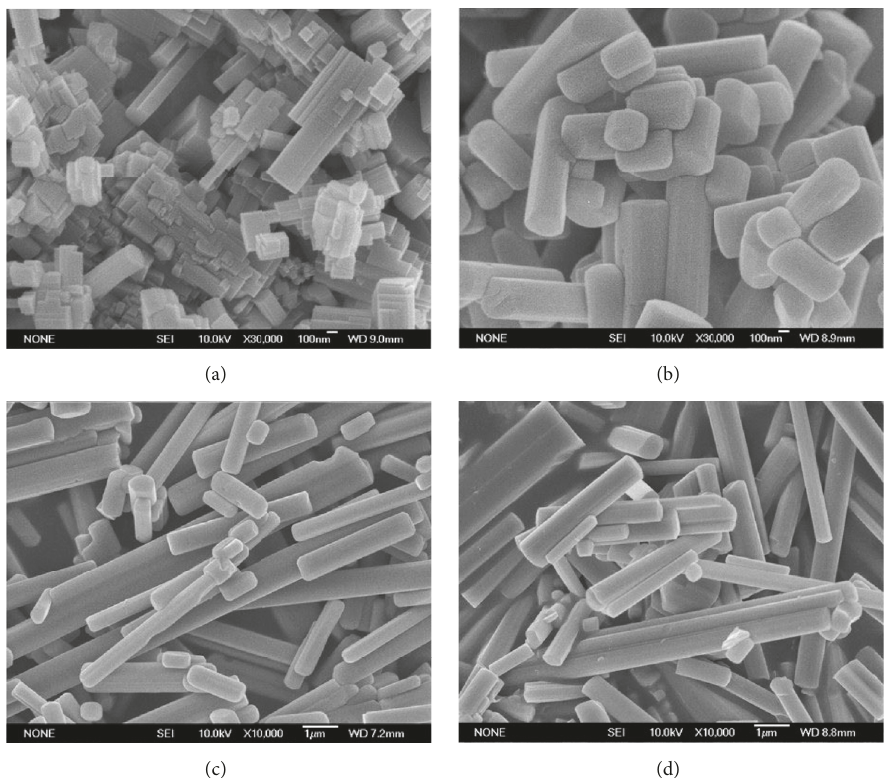
Figure 1: SEM images of the flux-synthesized SBN nanocrystals with flux-to-reactant weight ratio of 2 :1 at a reaction temperature of 1100 ∘ C for 3 h: (a) SBN20, (b) SBN40, (c) SBN60, and (d)